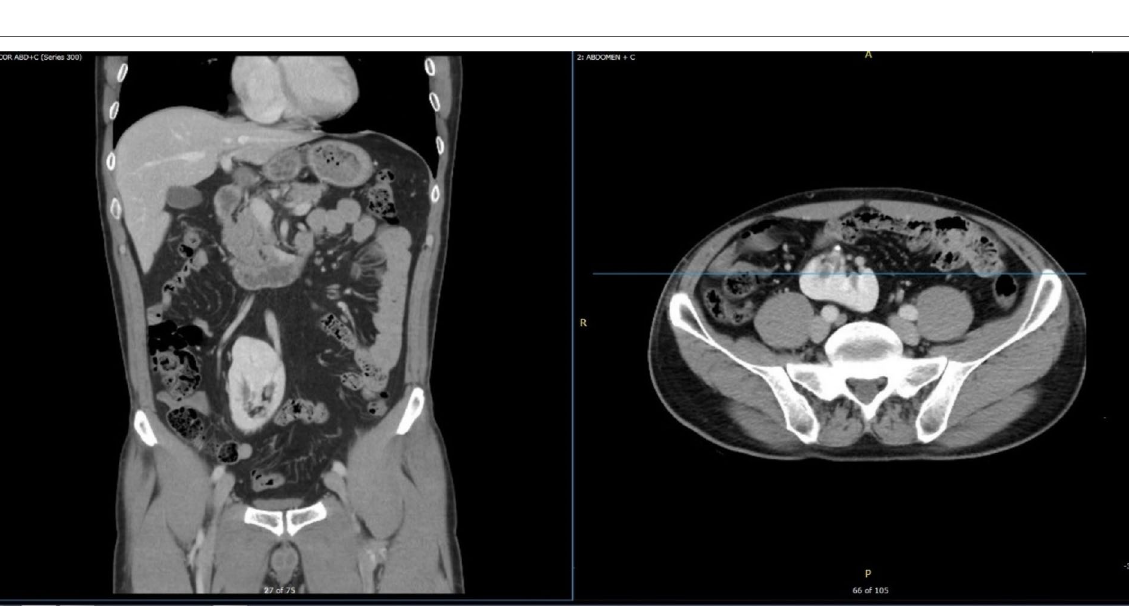
Fig. 3 CT abdomen, showing anterior malrotated ectopic right kidney with small stone at pelviureteric